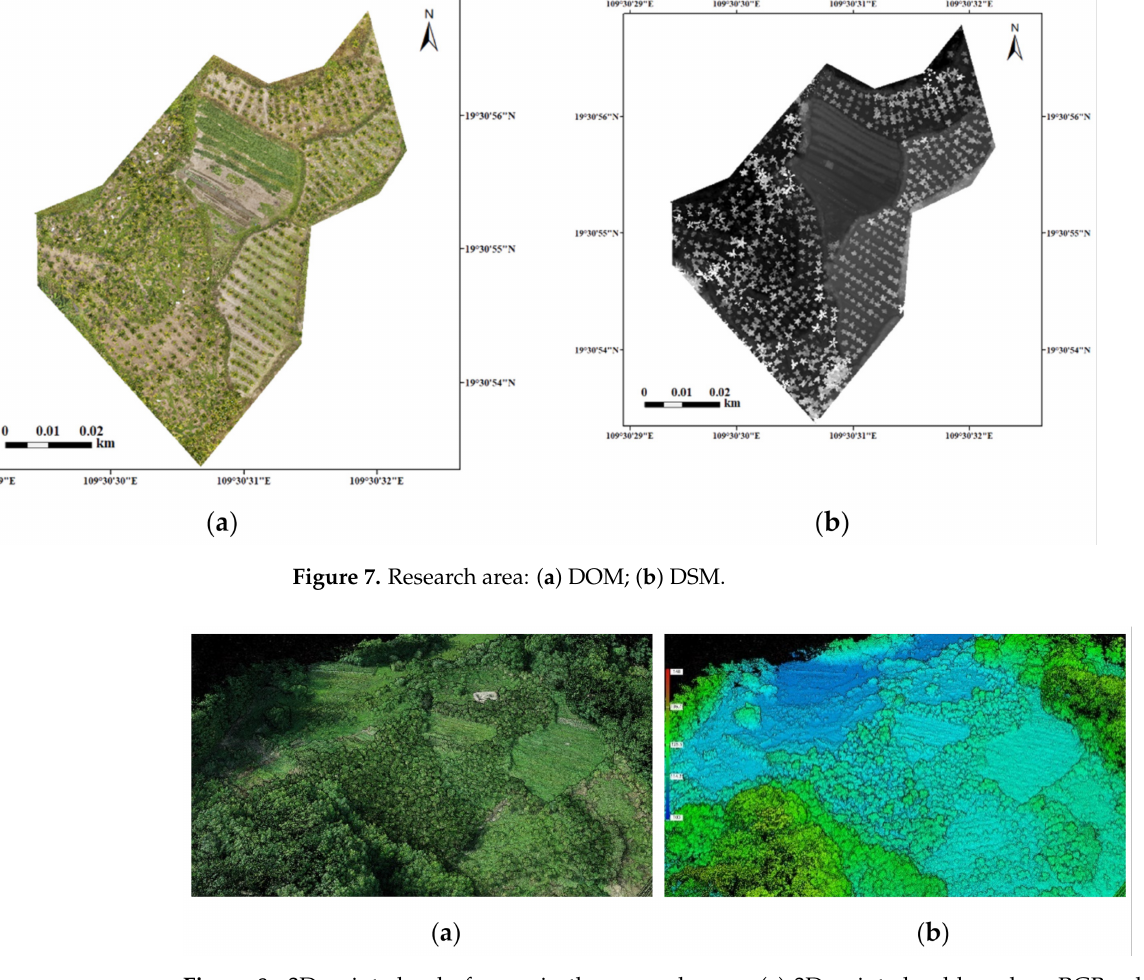
Figure 8. 3D point cloud of areca in the research area: ( a ) 3D point cloud based on RGB color rendering; ( b ) 3D point cloud based on elevation color